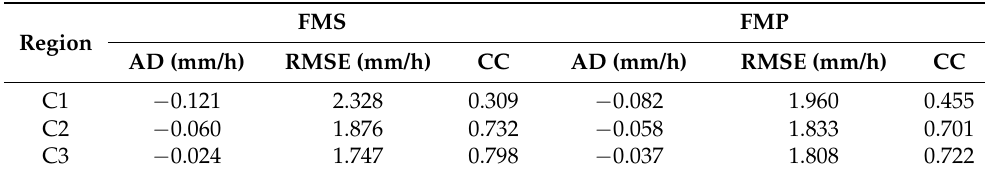
Table 1. Average deviations (AD), root-mean-square errors (RMSE), and correlation coefficients (CC) of the fusion methods under the three different regional network densities in China in July 2009. FMS, the fusion method proposed by Shen et al. ([28]), FMP, the fusion method proposed in this